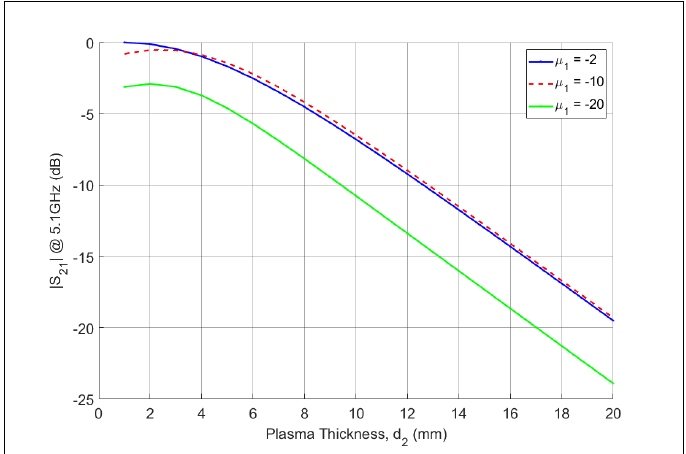
Figure 18. Transmission as the plasma thickness, d 2 , increases for different values of µ 1 r .